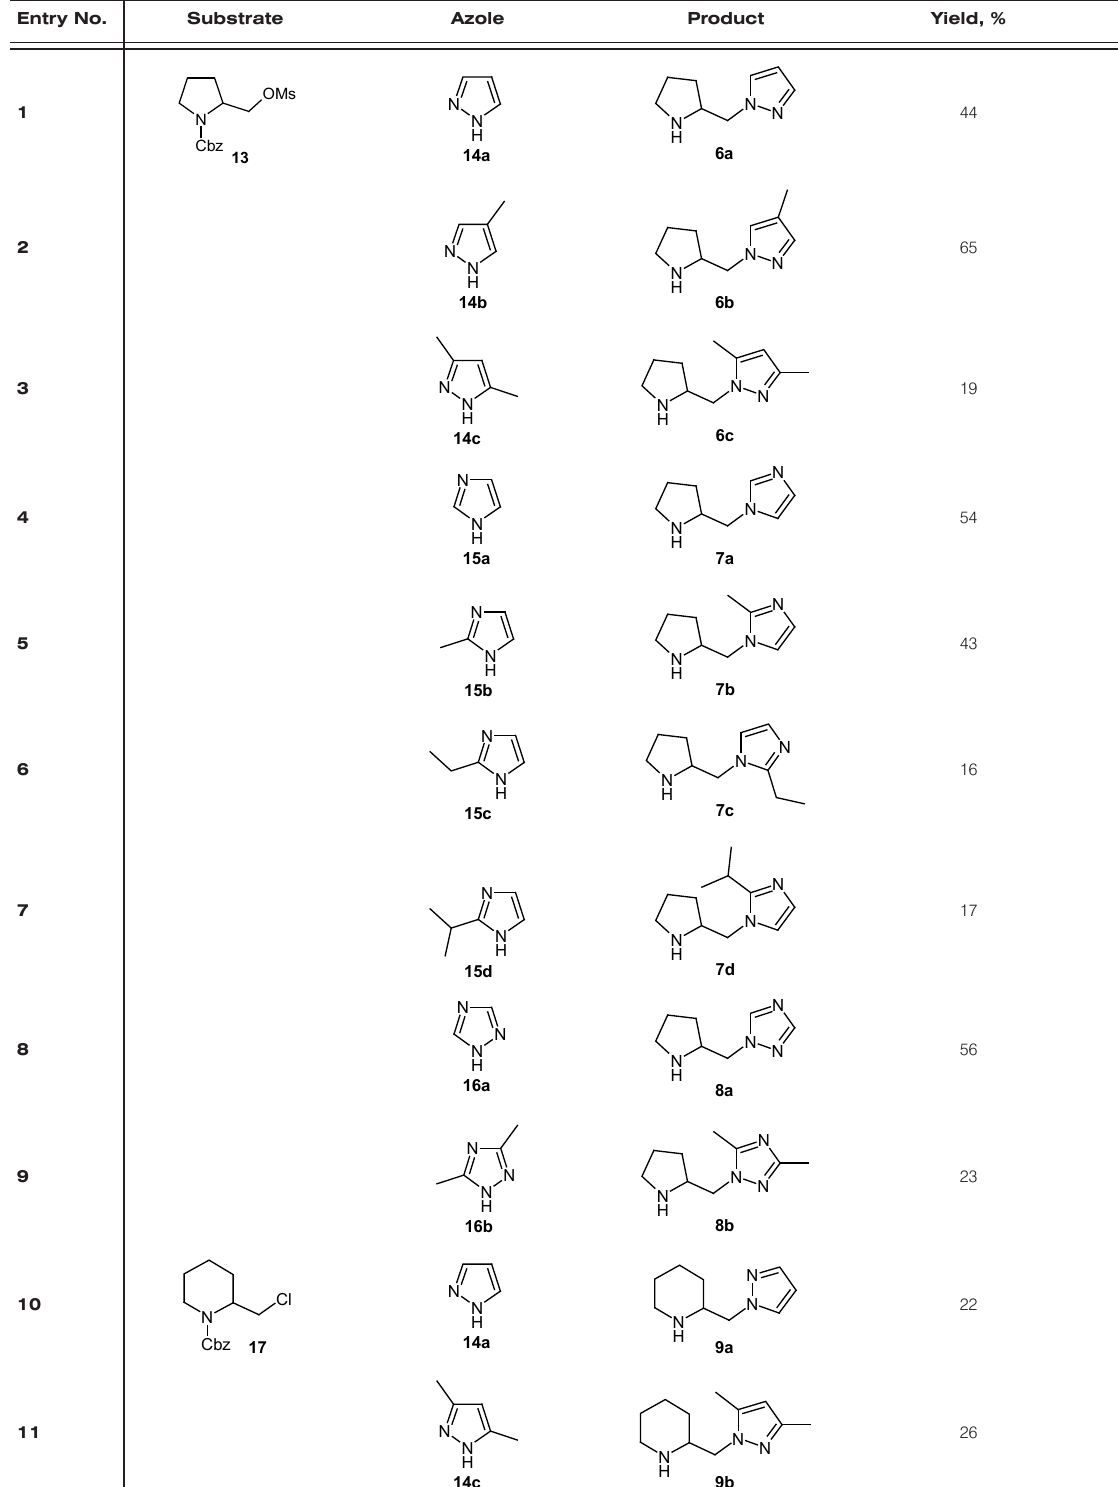
Table 1. Synthesis of 1-(pyrrolidinylmethyl)-1 H -azoles and their piperidine-derived homologues 6 – 11 . Conditions: (cid:11)(cid:76)(cid:12)(cid:3)(cid:49)(cid:68)(cid:43)(cid:3)(cid:11)(cid:20)(cid:3)(cid:72)(cid:84)(cid:12)(cid:15)(cid:3)(cid:39)(cid:48)(cid:41)(cid:15)(cid:3)(cid:25)(cid:19)(cid:350)(cid:38)(cid:3) (cid:15)(cid:3)(cid:20)(cid:19)(cid:8)(cid:3)(cid:51)(cid:71)(cid:16)(cid:38)(cid:15)(cid:3)(cid:48)(cid:72)(cid:50)(cid:43)(cid:15)(cid:3)(cid:20)(cid:3)(cid:68)(cid:87)(cid:80)(cid:15)(cid:3)(cid:85)(cid:87)(cid:15)(cid:3)(cid:80)(cid:82)(cid:81)(cid:76)(cid:87)(cid:82)(cid:85)(cid:72)(cid:71)(cid:3)(cid:69)(cid:92)(cid:3)(cid:49)(cid:48)(cid:53)(cid:17) (cid:3) (cid:3)(cid:3)(cid:3)(cid:3)(cid:3)(cid:3)(cid:82)(cid:85)(cid:3)(cid:20)(cid:19)(cid:19)(cid:350)(cid:38)(cid:15)(cid:3)(cid:27)(cid:98)(cid:75)(cid:30)(cid:3)(cid:11)(cid:76)(cid:76)(cid:12)(cid:3)(cid:43) 2 Entry No. Substrate Azole Product Yield,